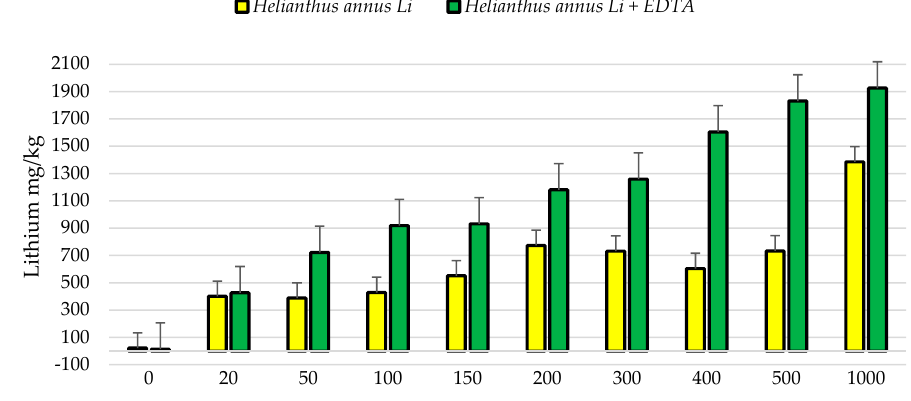
Figure 5. x ̅ Li concentration in leaves of Helianthus annuus from trial 1 (no chelator) and Helianthus annuus from trial 2 (EDTA treatments at 0.05M). X-axis, concentration of Li amended to soil. (Units in mg/kg).